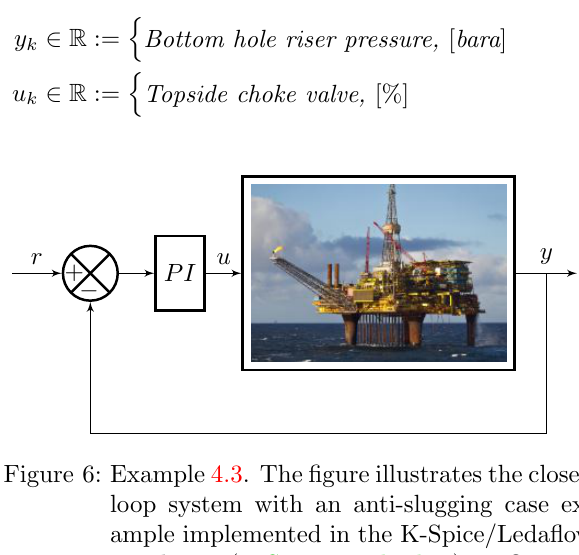
Table 3: Example